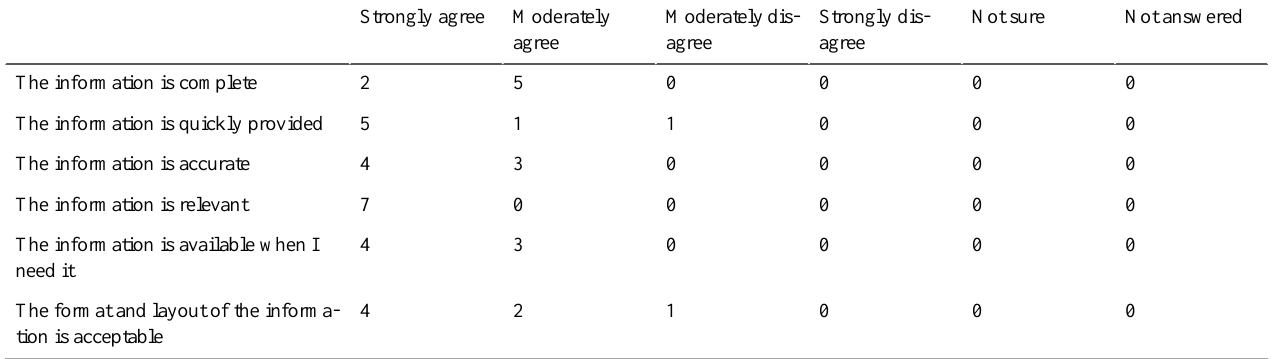
Table 3. Information quality ratings